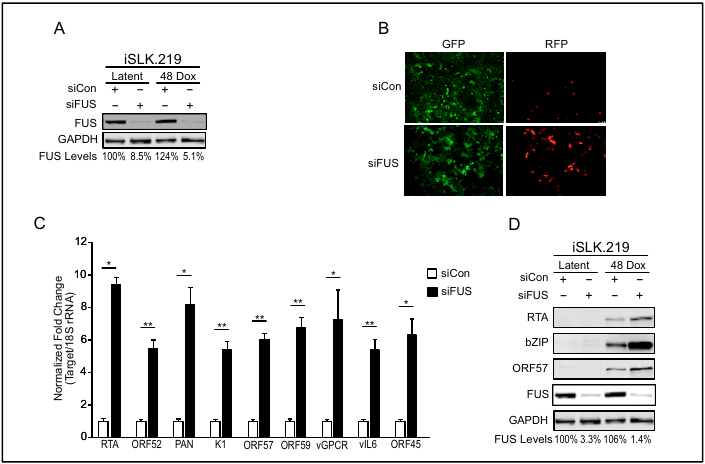
Figure 2. FUS represses KSHV reactivation in iSLK.219 cells. ( A ) iSLK.219 cells were treated with siRNA against FUS for 48 h, followed by doxycycline-induced reactivation of KSHV for 48 h. Knockdown efficiency in latency and 48 h post-reactivation was determined by western blot and is indicated beneath each lane. GAPDH was used as a loading control. ( B ) Fluorescent microscopy, at 10 × magnification, of iSLK.219 cells depleted of FUS by siRNA in ( A ). ( C ) RT-qPCR of viral transcripts from FUS-depleted iSLK.219 cells in ( A ). All samples were normalized to 18S and siCon levels set to 1. ( D ) Western blot of viral proteins from cells in ( A ). GAPDH was used as a loading control. Student t test used to determine statistical significance * p ≤ 0.05. ** p ≤